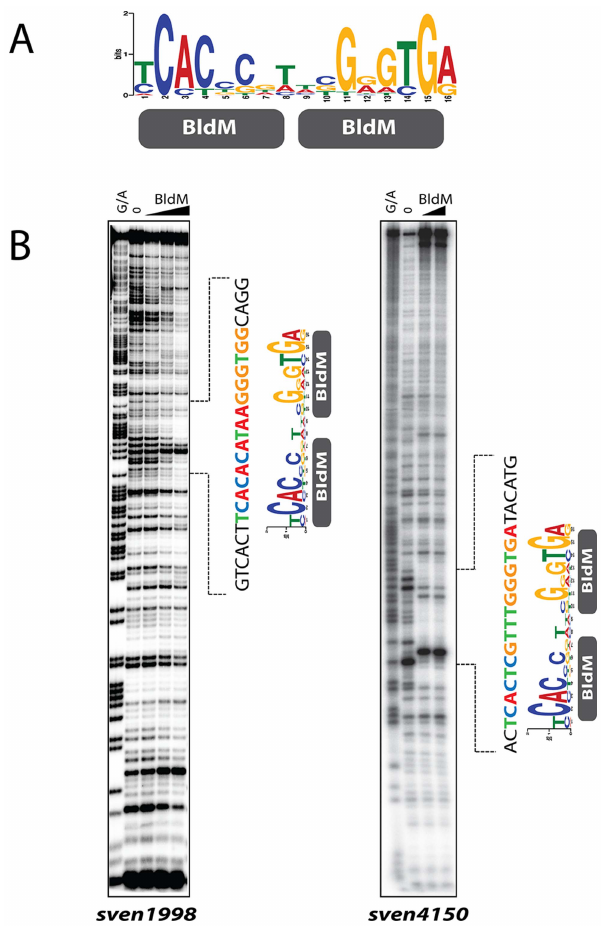
Figure 2. BldM binds to the MEME -predicted Group-I consensus sequence. A. The MEME -predicted palindromic Group-I consensus sequence. The height of the letters in the sequence logo, in bits, is proportional to the frequency of the A, C, T, or G nucleotides at each position of the motif. B. DNase I footprinting analysis of BldM on two Group-I promoters: sven1998 and sven4150 . The BldM protein concen- trations used were 0, 100, 250 and 500 nM for sven1998 and 0, 250 and 500 nM for sven4150 . G + A indicates the Maxam and Gilbert sequence ladder. The protected regions are indicated by dotted lines and the positions of the MEME -predicted Group I binding motif are